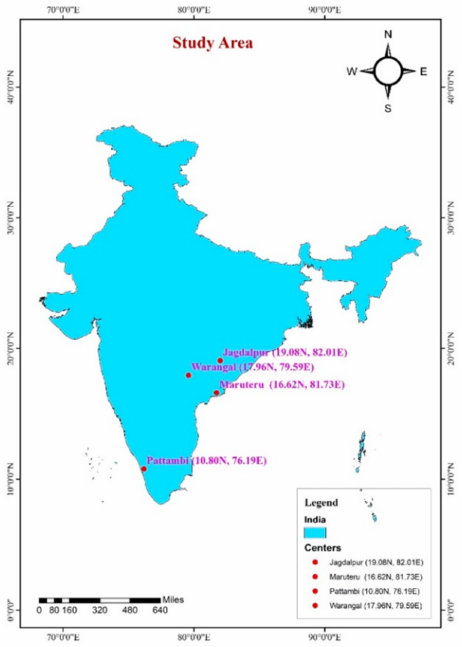
Figure 2. Study sites for rice gall midge population